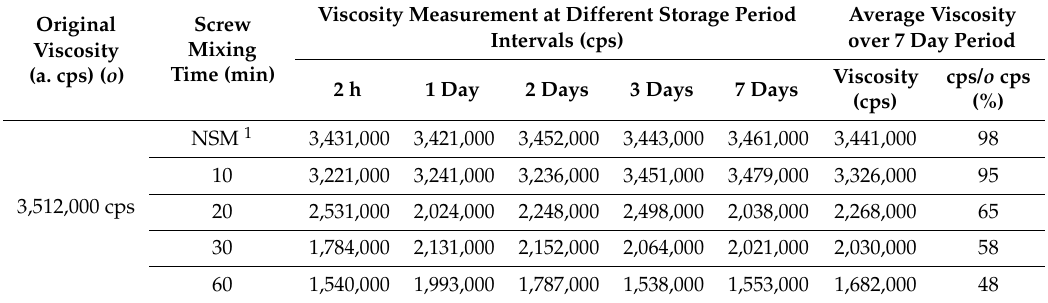
Table 5. Viscosity measurement in accordance with predetermined screw-mixing and storage times.